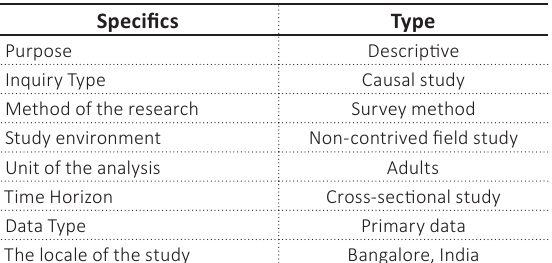
Table 1. Research